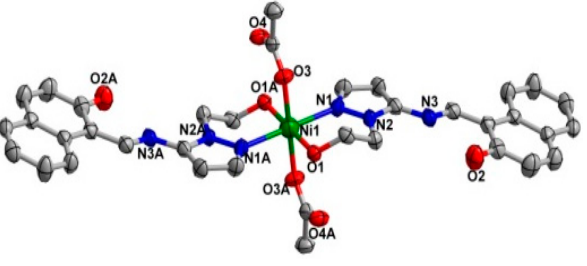
Figure 1. X-ray crystal structure of complex 1 along with atomic numbering, hydrogen atoms have been omitted for clarity.